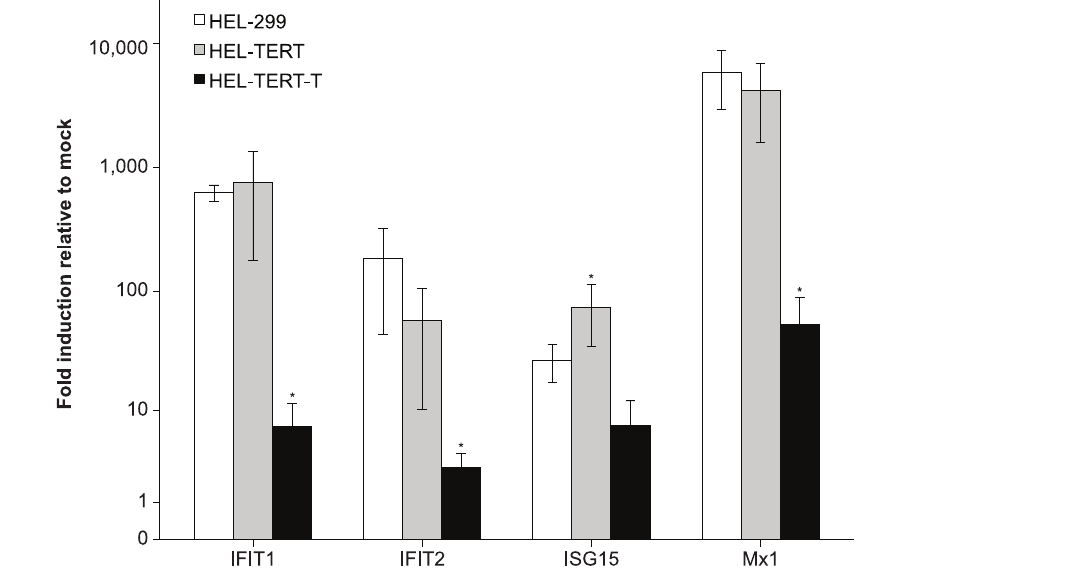
Figure 4. HEL-TERT but not HEL-TERT-T cells show ISG induction at levels similar to HEL-299 cells after IFN stimulation. HEL-299 and HEL-TERT cells were treated or mock treated with 1000 U/mL of human IFN- b . At 9 hours post treatment, total RNA was isolated from cells and reversed transcribed into cDNA for qRT-PCR analysis to monitor IFIT1 , IFIT2 , ISG15 , and Mx1 transcript levels. Data represents the means of 6 samples; error bars represent the standard errors of the means. * p , 0.05, one-way ANOVA, Bonferroni’s multiple comparison post-test, compared to HEL-299 levels.